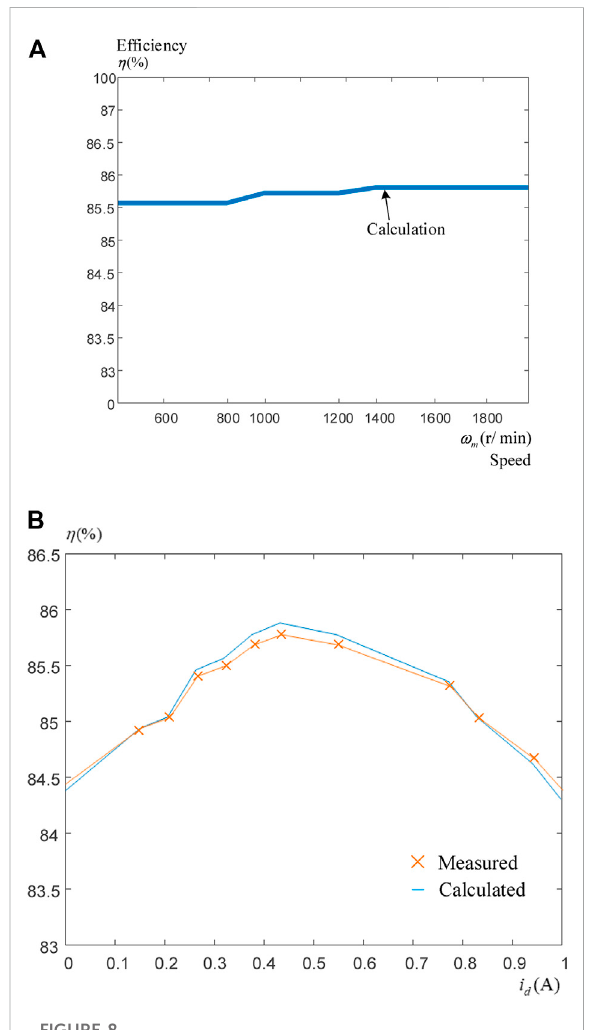
FIGURE 8 The relationshipbetweenef fi ciency and speed and ef fi ciency and d-axis current. (A) Ef fi ciency and speeds (B) ef fi ciency and the d-axis current at 600 r/min and 3 N m load.